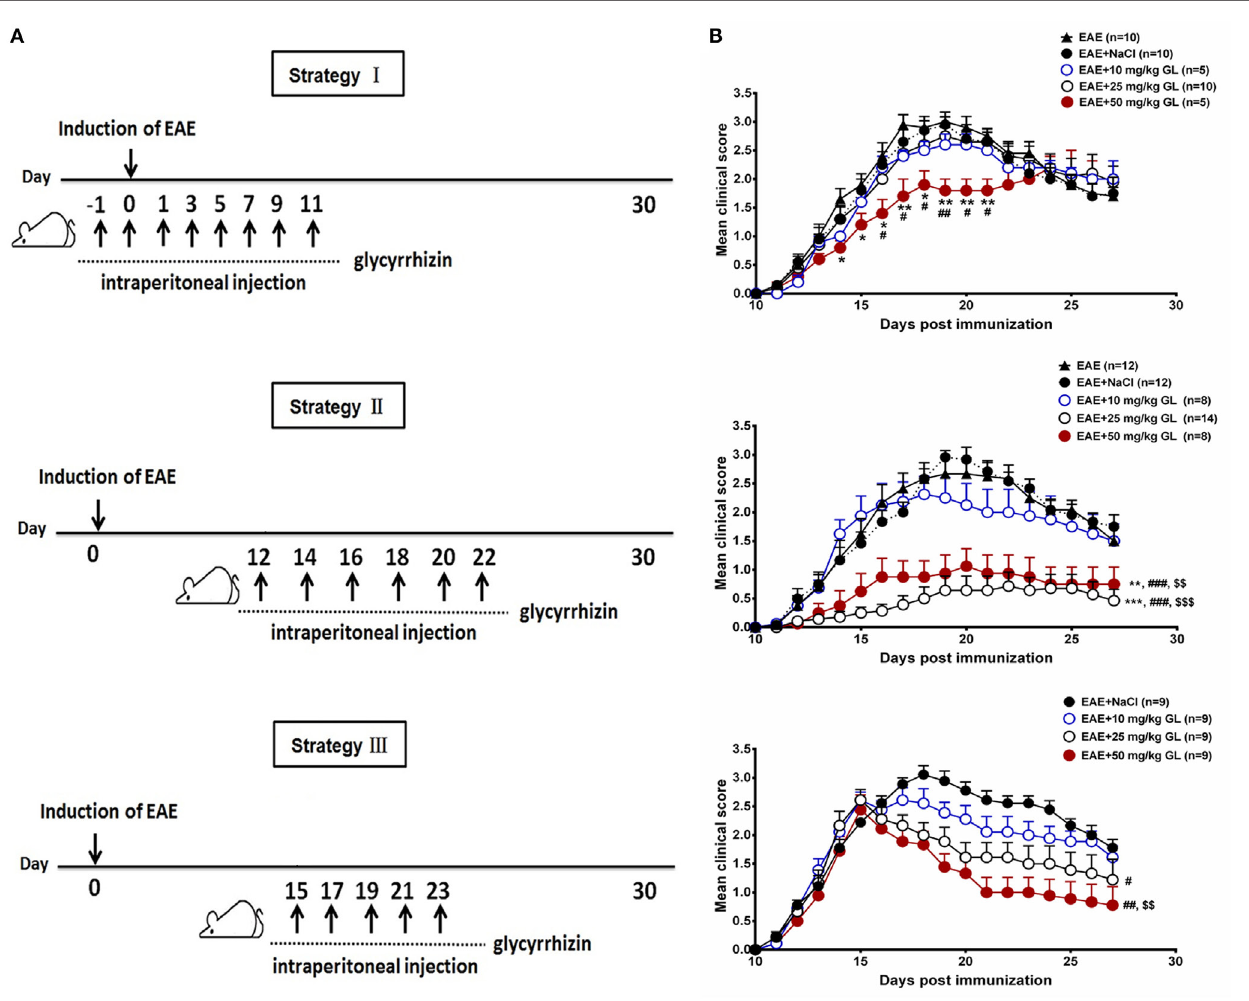
FigUre 1 | The effects of glycyrrhizin (GL) on the development of experimental autoimmune encephalomyelitis (EAE). (a) Schematic workflow of GL treatment. Mice were injected i.p. with 10, 25, or 50 mg/kg GL or 0.9% NaCl each time. (B) The effects of different concentrations of GL treatment on disease score. Mice were injected i.p. from days − 1 to 11 (strategy I), days 12 to 22 (strategy II), or days 15 to 23 (strategy III) with GL or NaCl. * P < 0.05, ** P < 0.01, *** P < 0.001 vs EAE group; # P < 0.05, ## P < 0.01, ### P < 0.001 vs EAE + NaCl group, $$ P < 0.01, $$$ P < 0.001 vs EAE + 10 mg/kg GL group, using the Mann–Whitney U test for the time point or cumulative disease score. The results shown represent one experiment or two independent